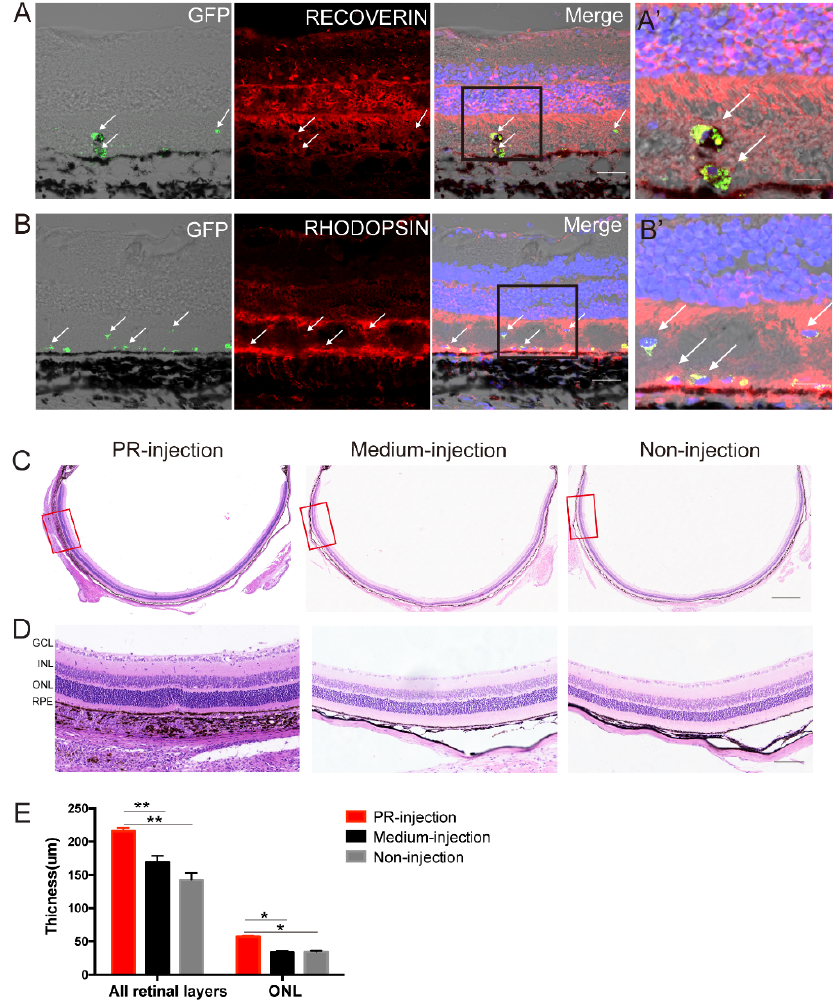
Figure 5. Transplanted hAESCs–PR–like cells provided structural store in RCS rat model. ( A , B ) Immunofluorescence staining showed GFP–labeled transplanted hAESCs–PR–like cells coexpressing photoreceptor markers Recoverin ( A ) and Rhodopsin ( B ); higher–magnification images of black frame in ( A ′ , B ′ ). ( C – E ) Representative images of H&E stained retina sections with histological quantifications, showing preservation of ONL and thicker whole retina in subretinal transplantation region compared to groups of control eyes; higher–magnification images of red frame in D, with quantification in E, n = 5. Score bars, 50 μ m in ( A , B ), 20 μ m in ( A ′ , B ′ ), 1 mm in ( C ), and 100 μ m in ( D ), error bars represent mean ± SEM. * p < 0.05, ** p < 0.01; unpaired t –test.